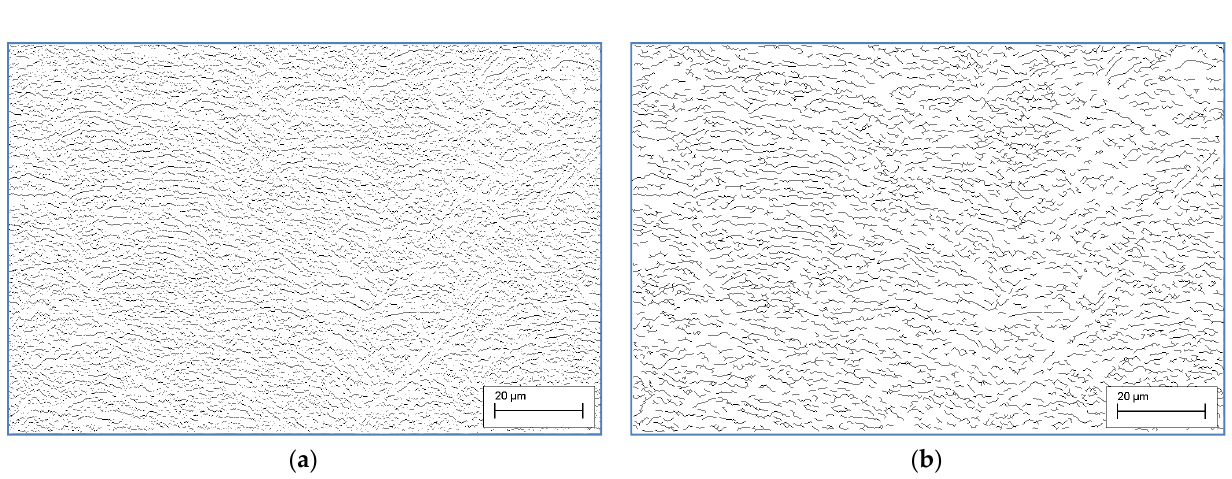
Figure 4. Binary image obtained after iterative selection of local minima ( a ), and the result of its morphological processing ( b ).